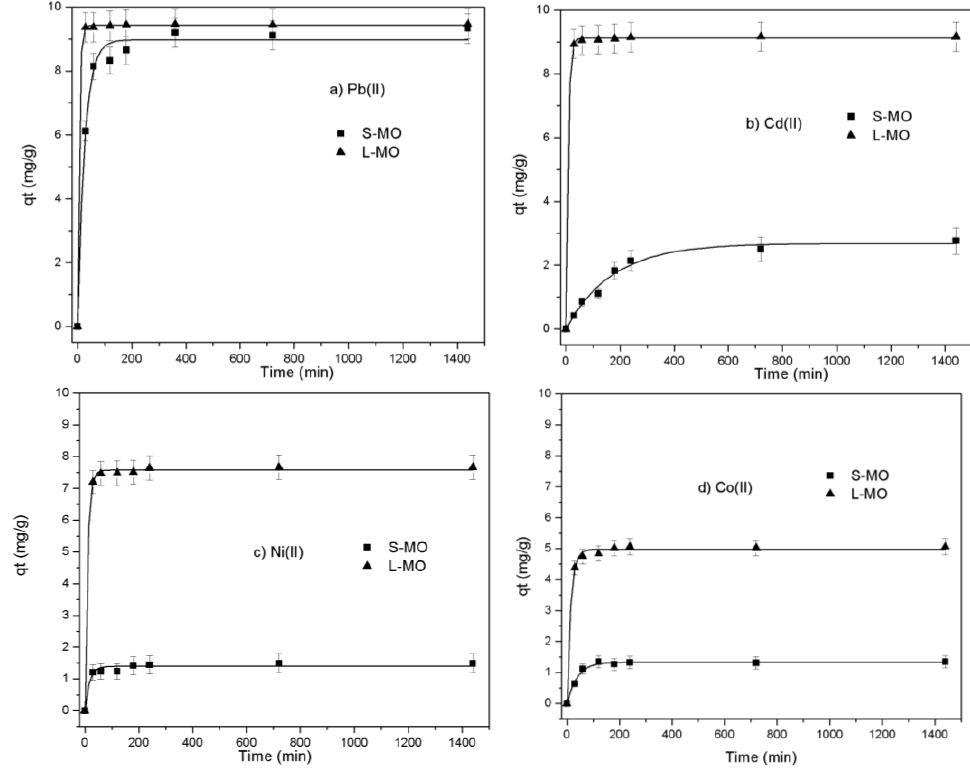
Figure 5. Heavy metal uptakes ( a ) Pb(II), ( b ) Cd(II), ( c )Ni(II) and ( d ) Co(II)) as a function of contact time at the following conditions: m =0.1 g; Ci = 100 mg/L; and pH = 6.